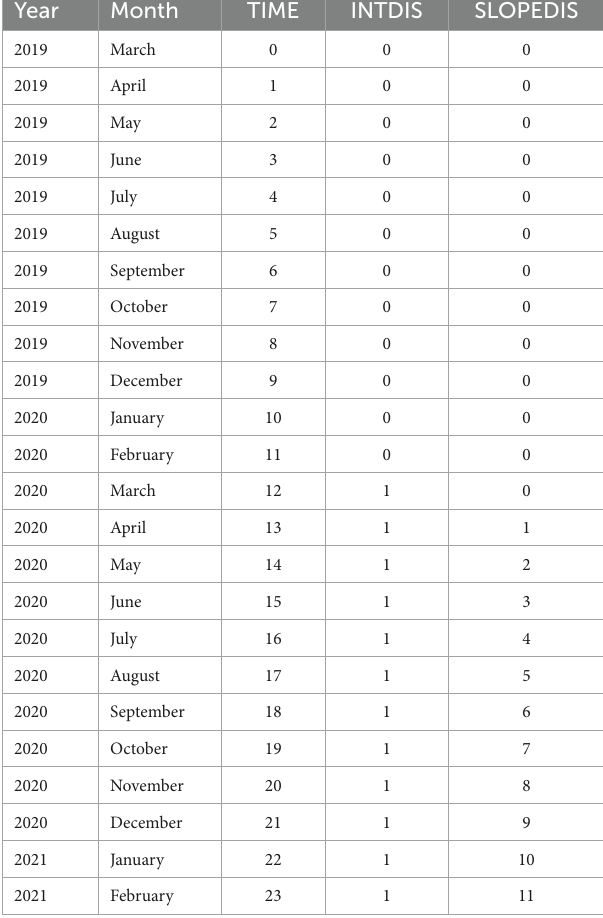
TABLE 2 Coding of time